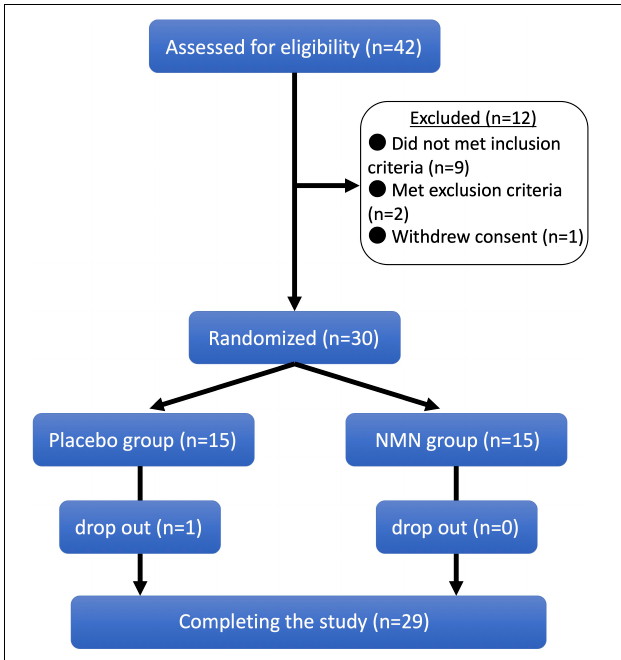
FIGURE 1 | Clinical trial diagram. Clinical trial diagram based on the CONSORT. A total of 42 potential participants were screened, and 30 eligible participants were selected and randomized into nicotinamide mononucleotide (NMN) and placebo groups in a 1:1 ratio. One participant in placebo group was dropped out from the study at 8-week, and 29 participants completed the study.